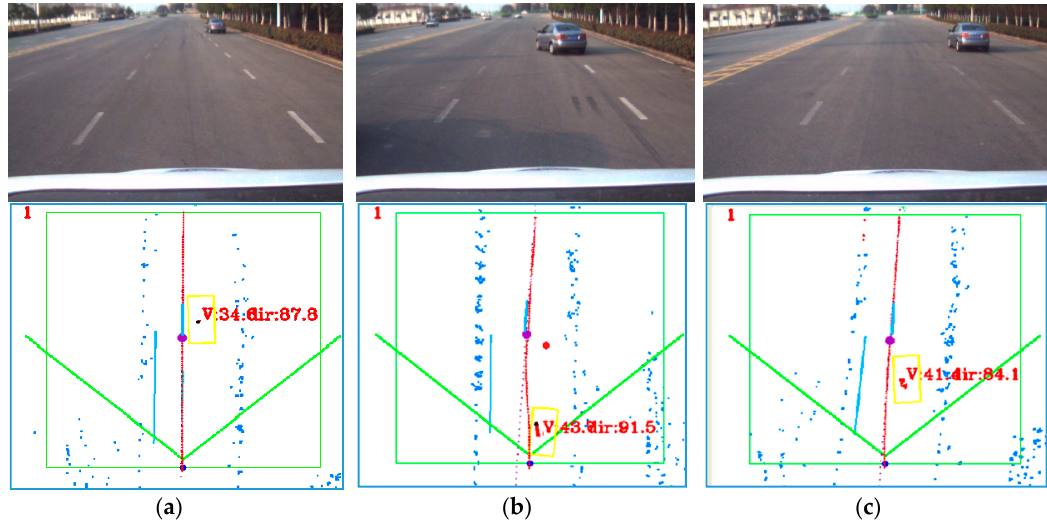
Figure 19. Collision avoidance without intent estimation. ( a ) No collision is detected; ( b ) changing lane to avoid a collision which is represented with a red point; ( c ) avoiding a potential collision successfully. The green box represents the dynamic obstacle detection range of the three-dimensional LIDAR, and the area between the two green lines illustrates the detection area of the IBEO LIDAR. The planned trajectory of the autonomous vehicle is represented with a red line. The velocity and moving direction of detected obstacles are written in red besides the detected obstacles.